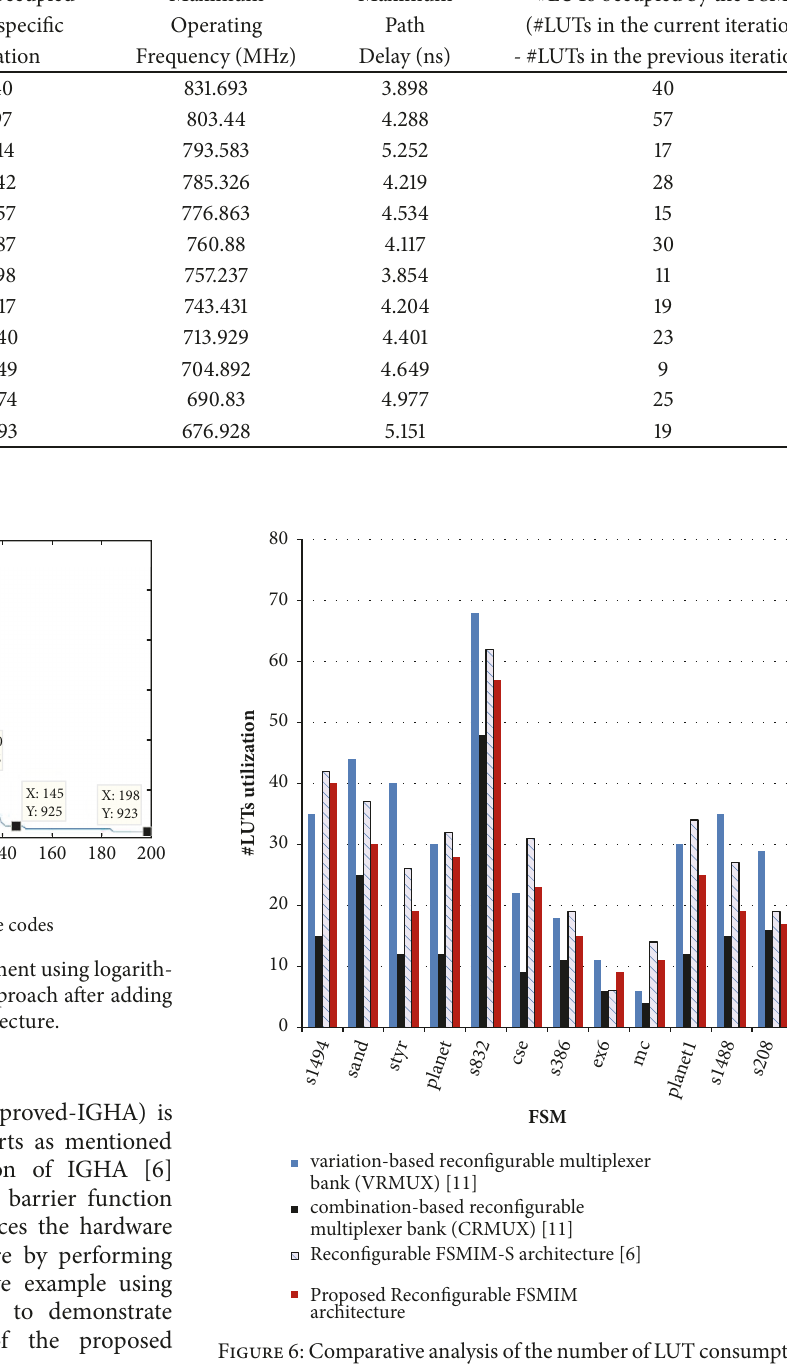
Figure 6: Comparative analysis of the numberof LUT consumption on FPGA implementation.